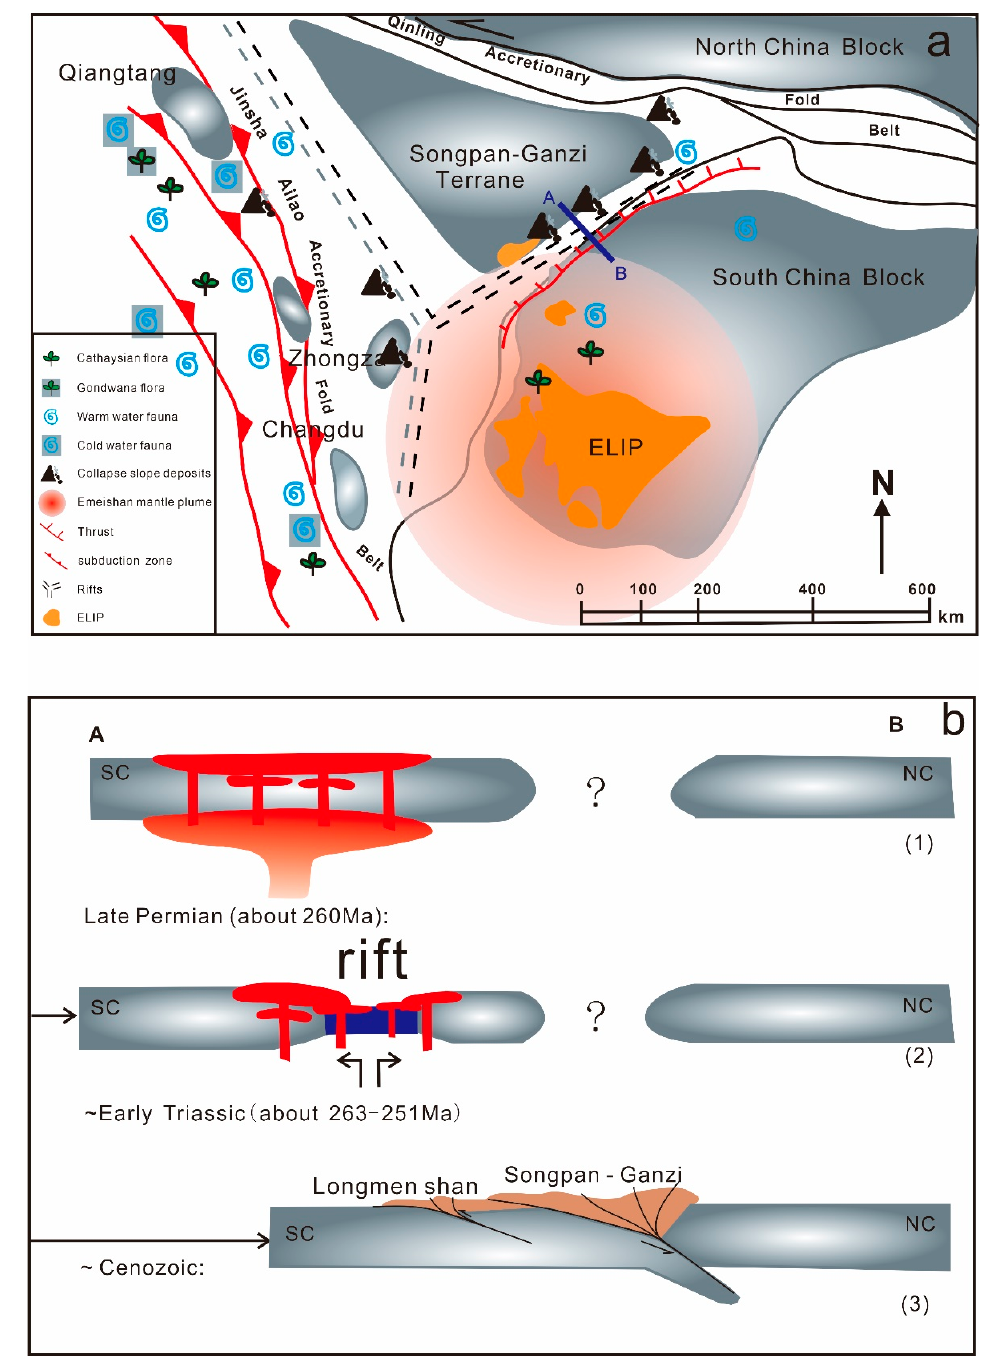
Figure 14. ( a ) Cartoon showing the Permian–Triassic triple junction of continental rifts (RRR) devel- oped in the Songpan–Ganzi Terrane (modified from [16,25]. AB: location of evolutionary sections of b. ( b ) Cartoons illustrating the tectonic evolution of northwest margin of the South China Block from Late Permian to Cenozoic: (1) Late Permian (about 260 Ma): mantle plume within the South China Block; (2) Early Triassic(about 263–251 Ma): the mantle plume triggers the separation of the SGT; (3) ~Cenozoic: Finally, the subduction and collision of the South China Block and North China Block, which produced extensive thrust nappe in southeastern margin of the SGT, strike–slip faults along the Longmen Shan tectonic belt, and a significant amount of thrust faulting and folding eventually overwhelmed the rift system and the rift finally closed. SC. South China Block, NC. North China Block.